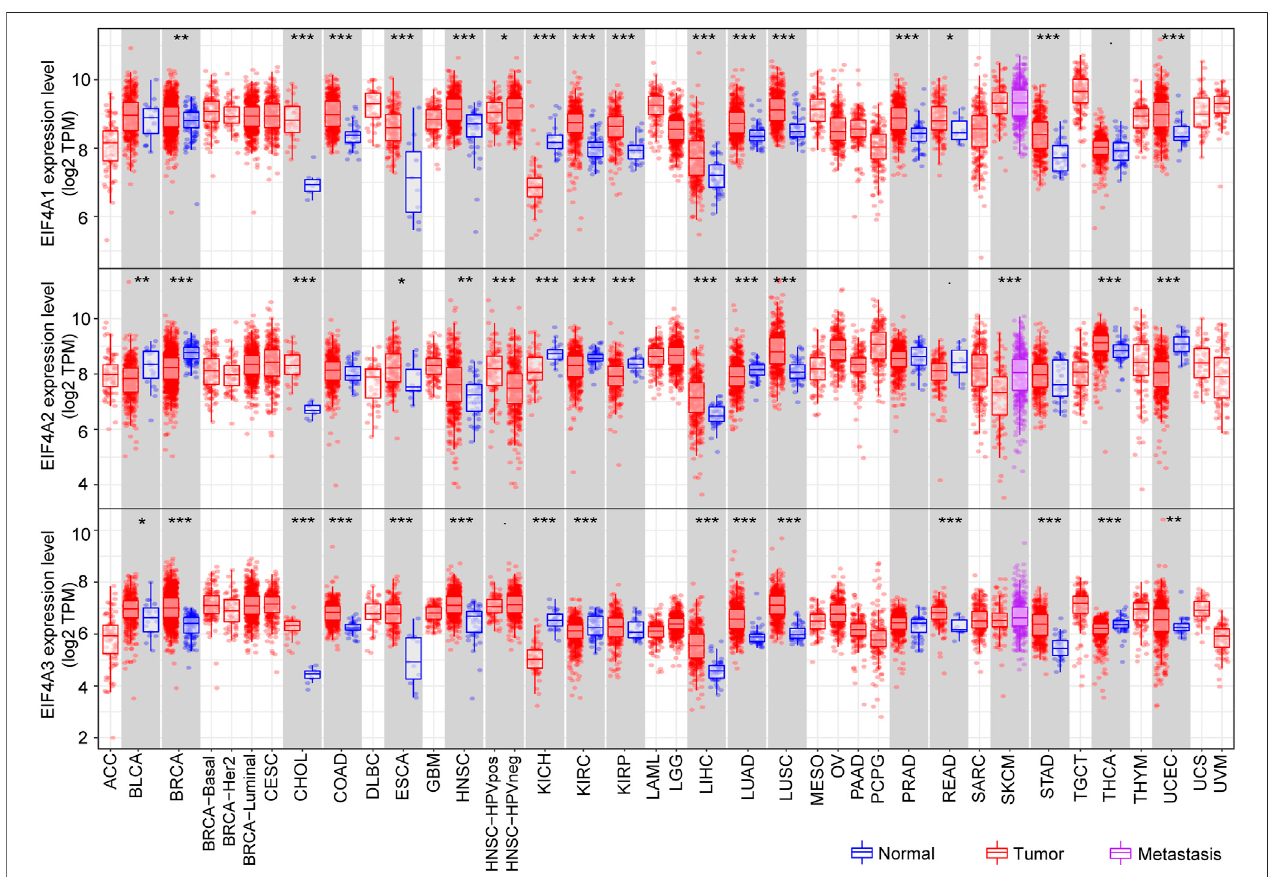
FIGURE 4 | eIF4A family gene mRNA expression levels. We adopted the TIMER website to detect the expression levels of eIF4Afamily genes. The results showed eIF4Afamily gene (eIF4A1, eIF4A2,and eIF4A3) mRNA expression levels in 32 tumor tissuescompared to normal tissues across multiple cancers. * p < 0.05, ** p < 0.01, *** p < 0.001. Abbreviations: Kidney RenalClear Cell Carcinoma (KIRC); Kidney Renal Papillary Cell Carcinoma (KIRP); Kidney Chromophobe(KICH);Brain Lower Grade Glioma (LGG); Glioblastoma Multiforme (GBM); Breast Invasive Carcinoma (BRCA); Lung Squamous Cell Carcinoma (LUSC); Lung Adenocarcinoma (LUAD); Rectum Adenocarcinoma (READ); Colon Adenocarcinoma (COAD); Uterine Carcinosarcoma (UCS); Uterine Corpus Endometrial Carcinoma (UCEC); Ovarian Serous Cystadenocarcinoma (OV); Head and Neck Squamous Carcinoma (HNSC); Thyroid Carcinoma (THCA); Prostate Adenocarcinoma (PRAD); Stomach Adenocarcinoma (STAD); Skin Cutaneous Melanoma (SKCM); Bladder Urothelial Carcinoma (BLCA); Liver Hepatocellular Carcinoma (LIHC); Cervical Squamous Cell Carcinoma and Endocervical Adenocarcinoma (CESC); Adrenocortical Carcinoma (ACC); Pheochromocytoma and Paraganglioma (PCPG); Sarcoma (SARC); Acute Myeloid Leukemia (LAML); Pancreatic Adenocarcinoma (PAAD); Esophageal Carcinoma (ESCA); Testicular Germ Cell Tumors (TGCT); Thymoma (THYM); Mesothelioma (MESO); Uveal Melanoma (UVM); Lymphoid Neoplasm Diffuse Large B-cell Lymphoma (DLBC); Cholangiocarcinoma (CHOL).